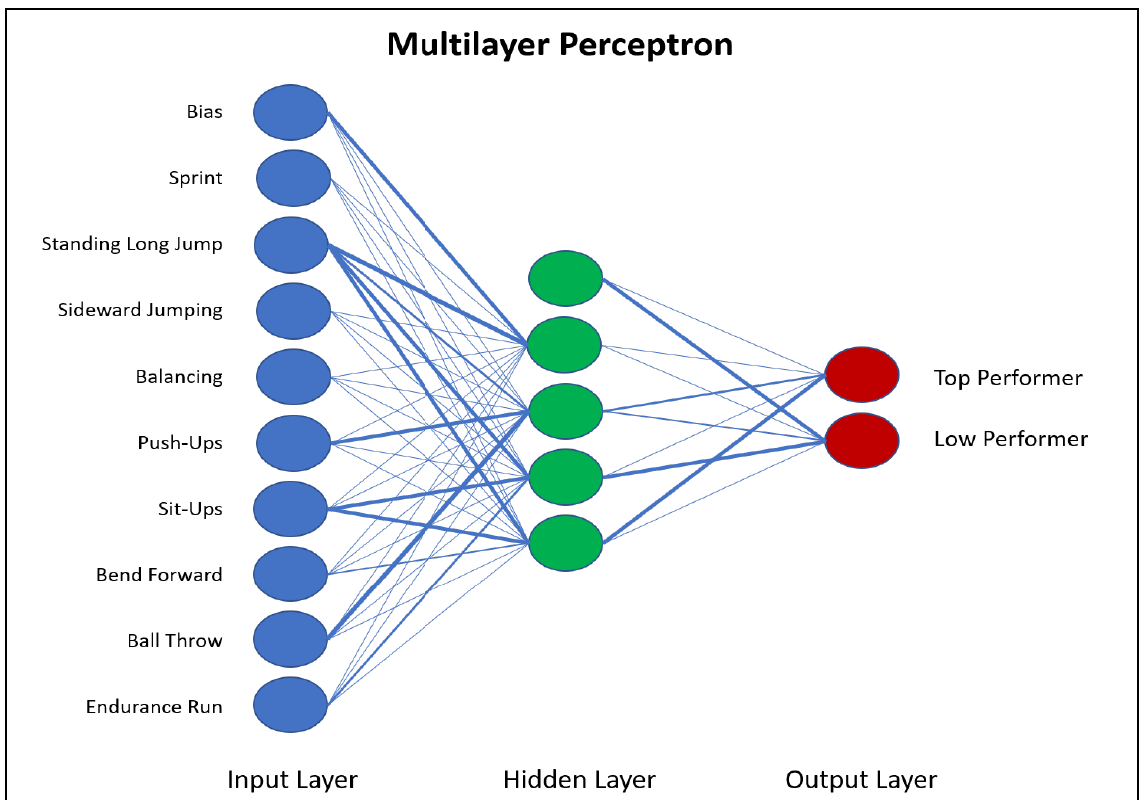
Figure 1. Example of a Neural Network (Multilayer Perceptron).